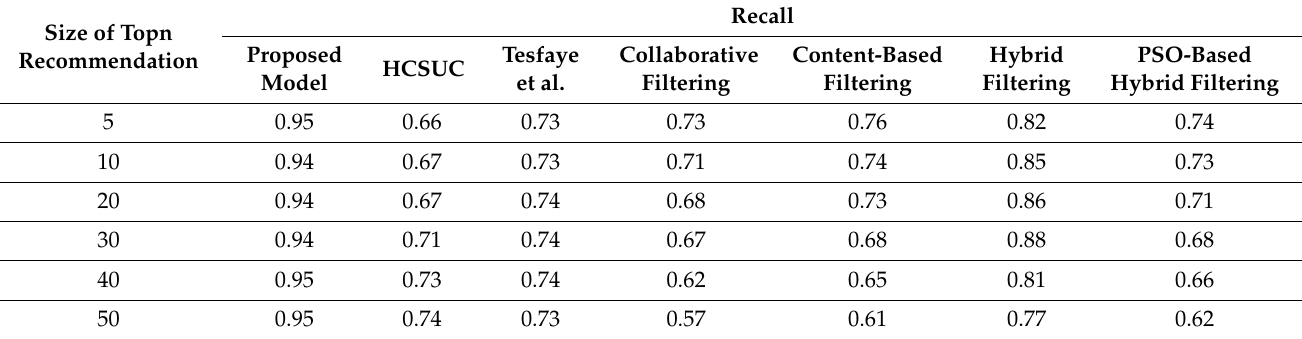
Table 12. Recall according to the Topn Recommendation (Considering Dataset 3